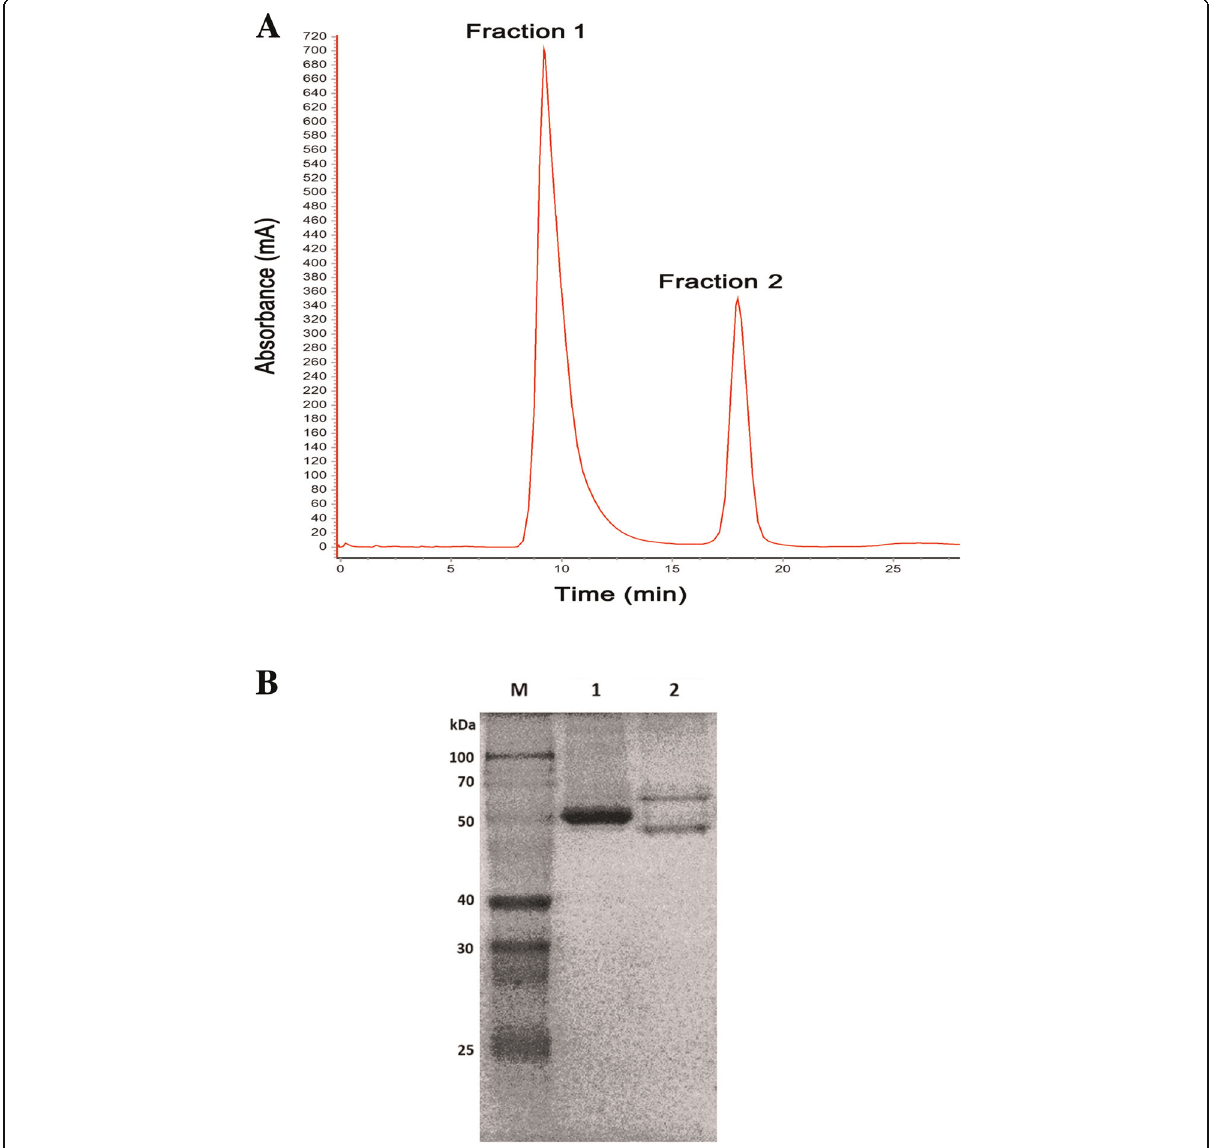
Fig. 1 Isolation of proteins from royal jelly. a Fractionation of royal jelly water-soluble proteins using an ÄKTA ™ pure system. The elution positions/ retention times of Fractions 1 and 2 are indicated. b SDS-PAGE analysis of the protein content of the collected fractions. Lane 1 and lane 2 are the proteins in Fractions 1 and 2, respectively. M represents molecular weight protein